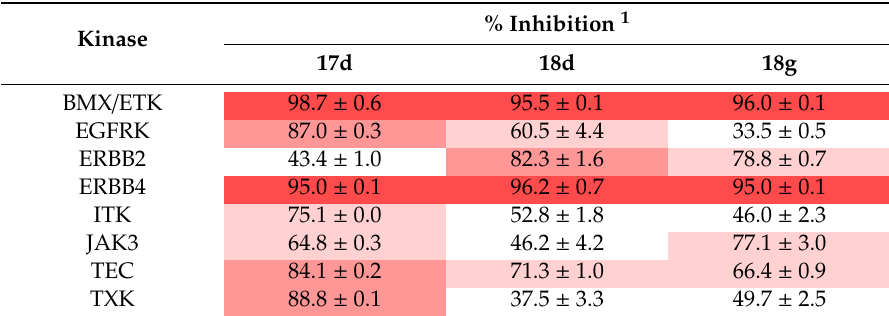
Table 3. Kinase selectivity profiles of 17d , 18d , and 18g .